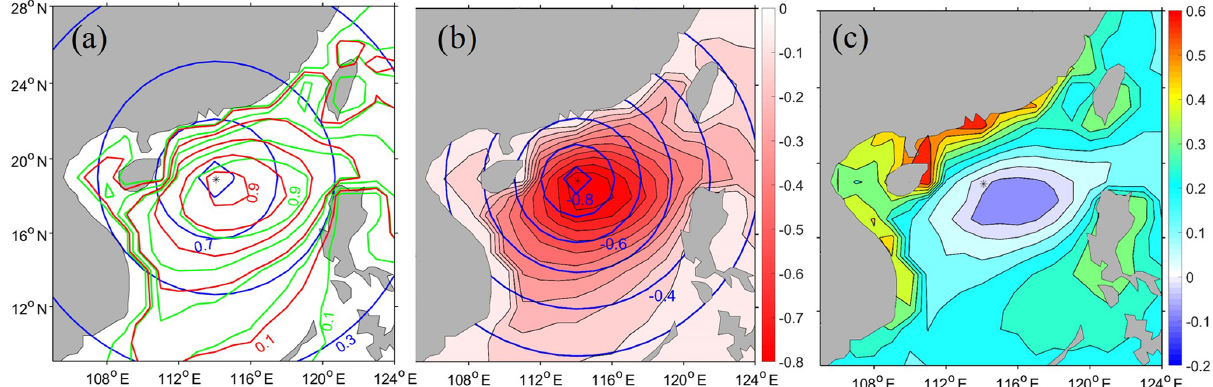
Figure 2. Spatial distributions of (a) background correlation coefficients by the empirical correlation model (blue), model data statistics (green) as well as their combination (red) of Eq. (3), (b) background adjustment increments of SWH projected from the observational increment with the empirical correction model (blue line) and their combination model (red filled), and (c) the difference in background adjustment increments of SWH from (b) by an analysis process given the single observation obtained at 18.90 ◦ N, 114.09 ◦ E, denoted by the asterisk (unit: